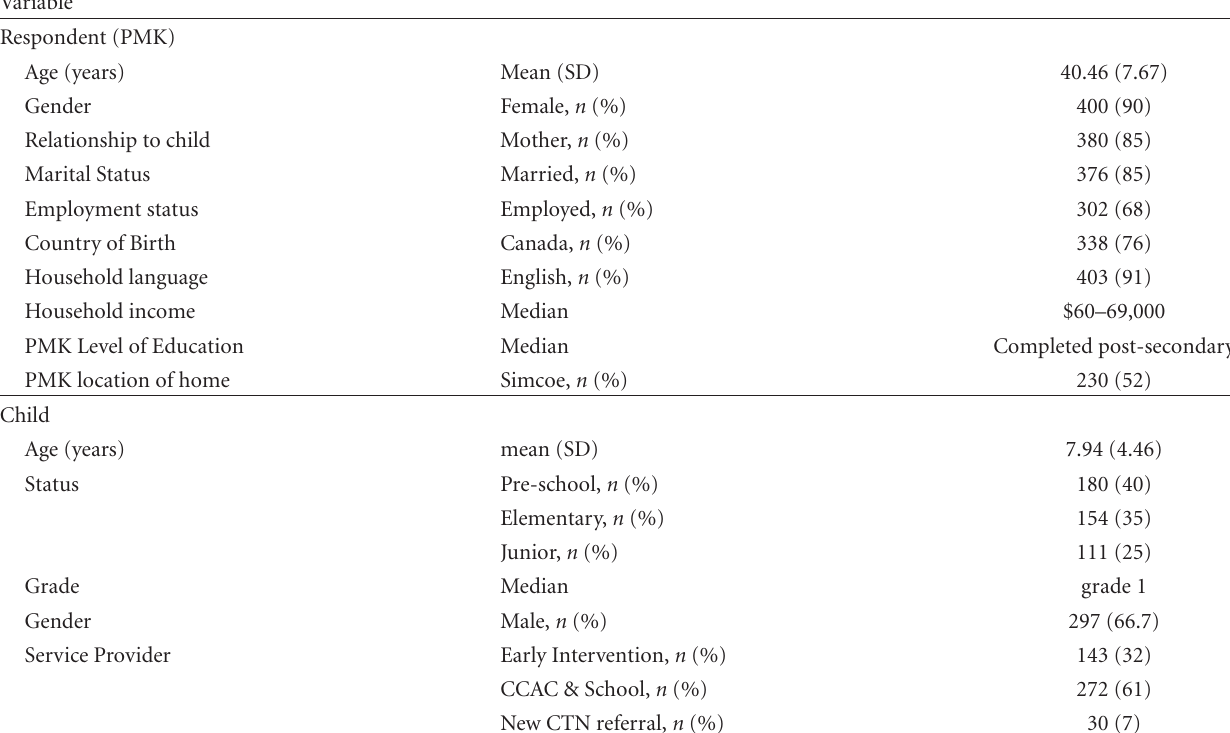
Table 1: Characteristics of sample ( n =